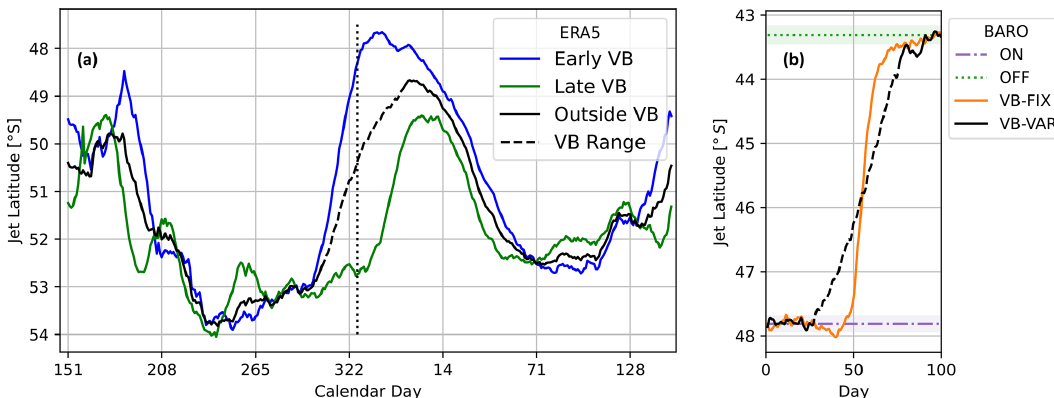
Figure 2. Climatological jet position. (a) Jet latitude in ERA5 based on zonal-mean zonal wind at 850hPa, smoothed with a 20d running window. Shown in black is the climatology, with the dashed part constituting the range of interannual vortex breakdown days which coincides with the equatorward jet shift in late austral spring to summer. The early and late VB years show an early and late jet shift respectively. The dotted vertical line represents the mean VB day. (b) Jet latitude in a simple barotropic model mimicking the late spring to austral summer transition, which is sharper in the absence of interannual VB variability (VB-FIX) compared with the varying case (VB-VAR).